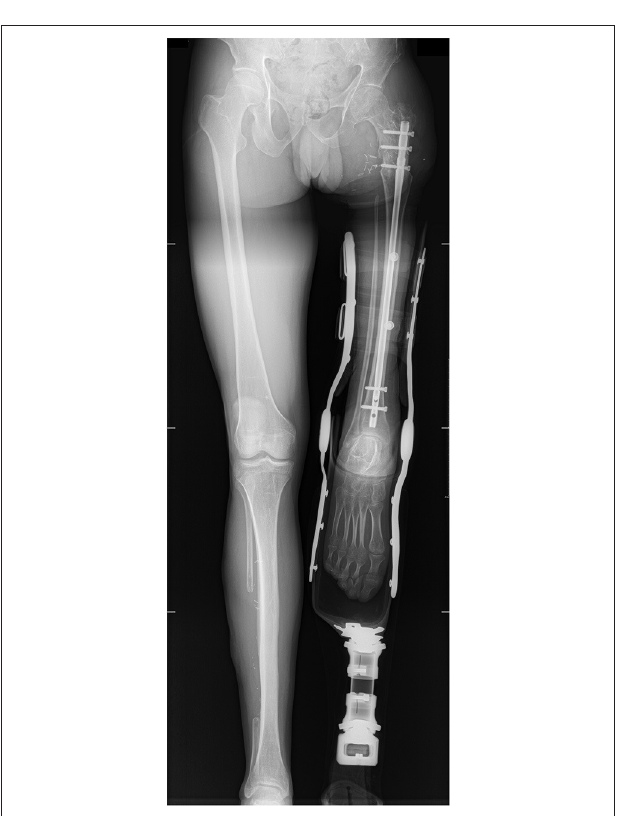
FIGURE 4 | Post-operative X-ray at last follow-up (2